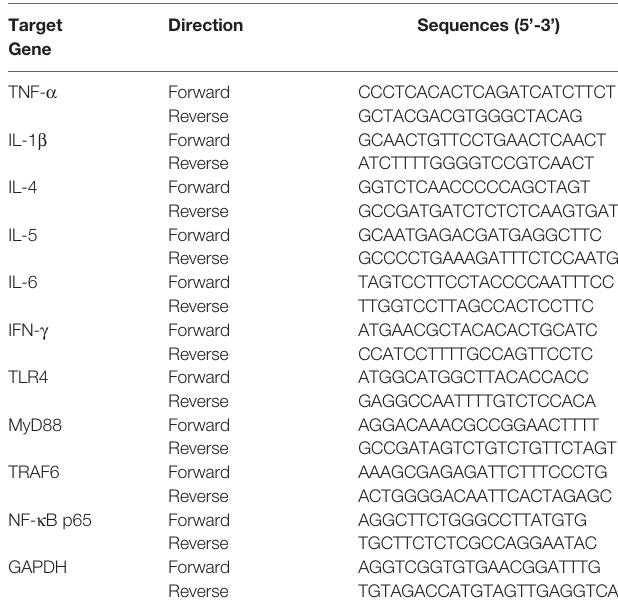
TABLE 1 | Primer sequences for